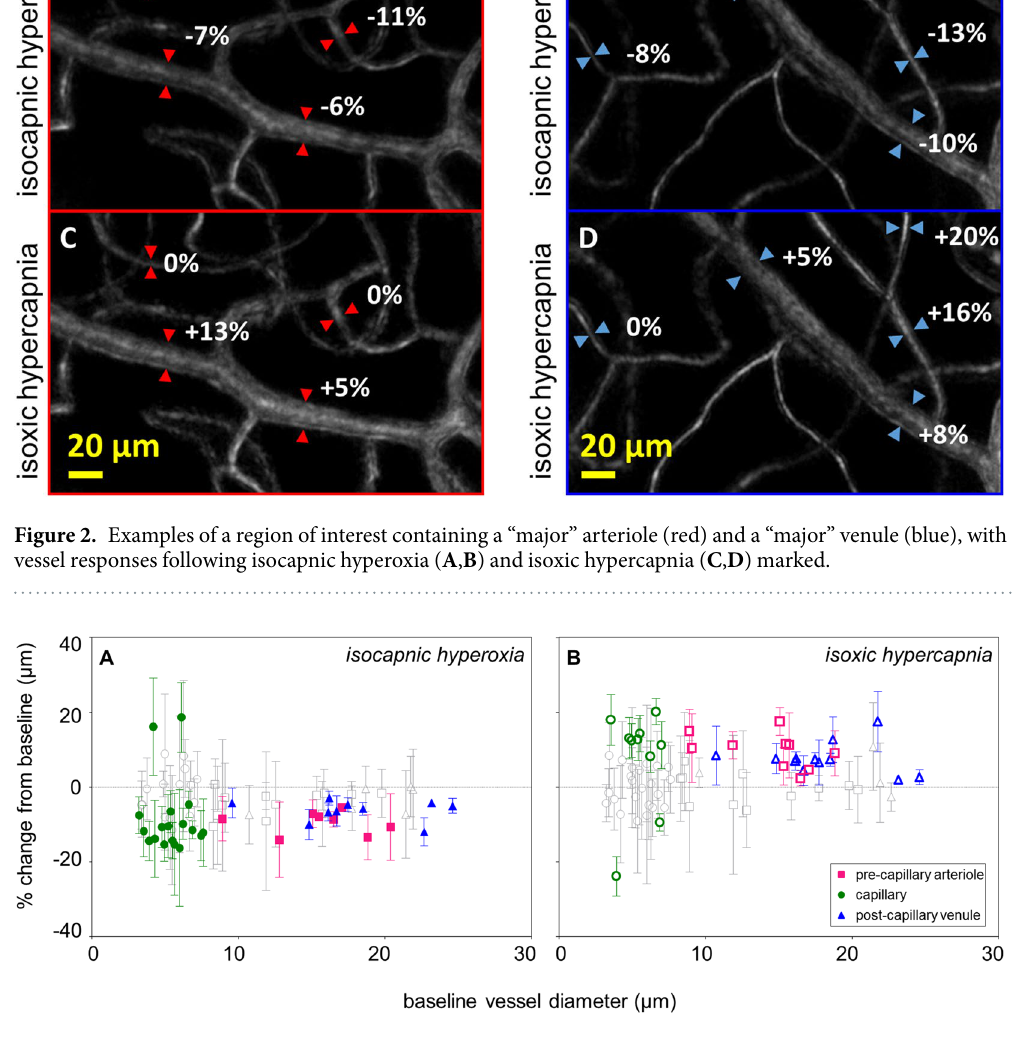
Figure 3. The proportional change from all 70 vessel segments analysed following isocapnic hyperoxia ( A ) and isoxic hypercapnia ( B ) with colored data points representing vessel segments demonstrating a definite response (whose 2 SEM error bars do not encompass zero), and grey data points representing vessel segments showing no measurable response (whose 2 SEM error bars encompass zero). There was a generalized constriction ( A ) following isocapnic hyperoxia and a generalized dilation ( B ) following isoxic hypercapnia. Proportional responses did not vary as a function of vessel size.